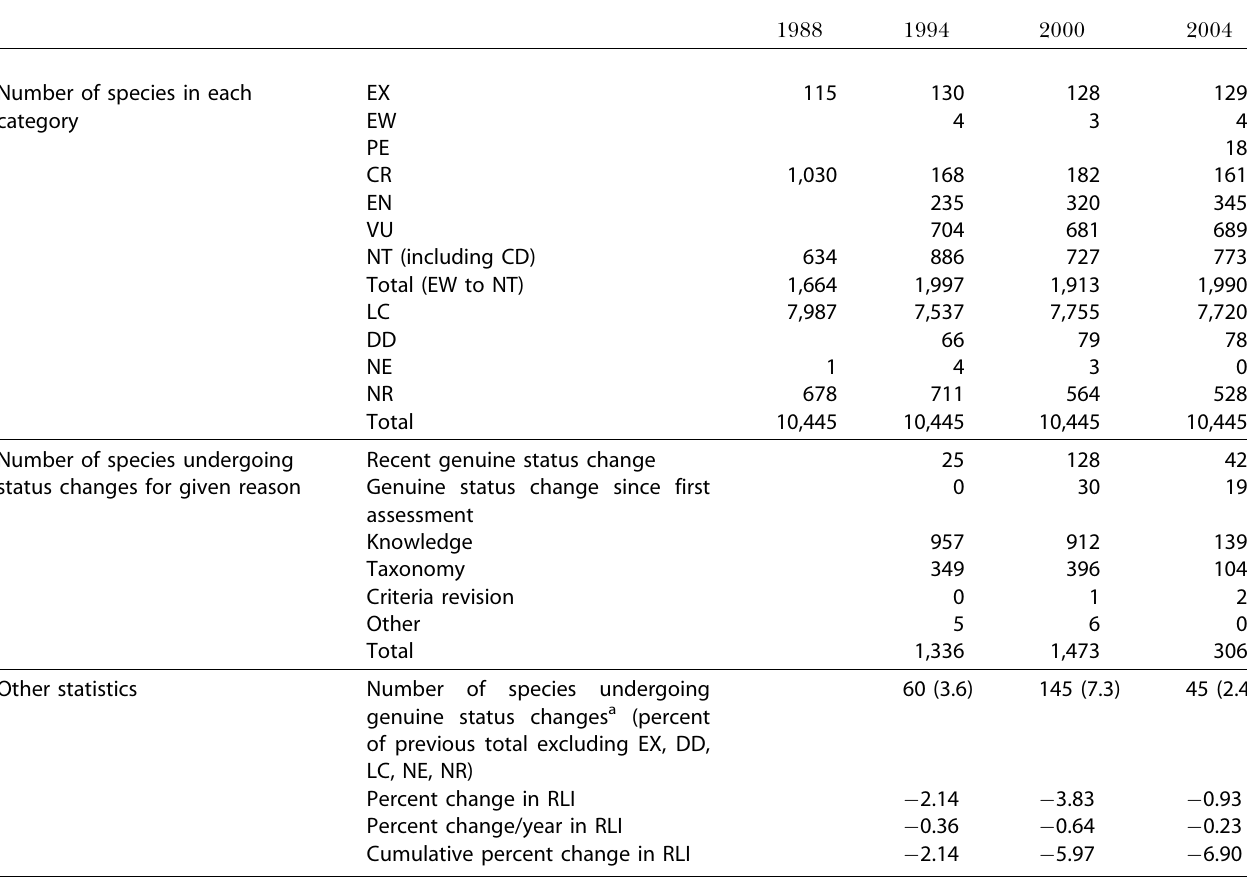
Table 2. Number of Species in Each IUCN Red List Category as Published in Collar and Andrew (1988), Collar et al. (1994), BirdLife International. (2000, 2004c), and the Number of Species Undergoing Genuine Status Changes in Each Period